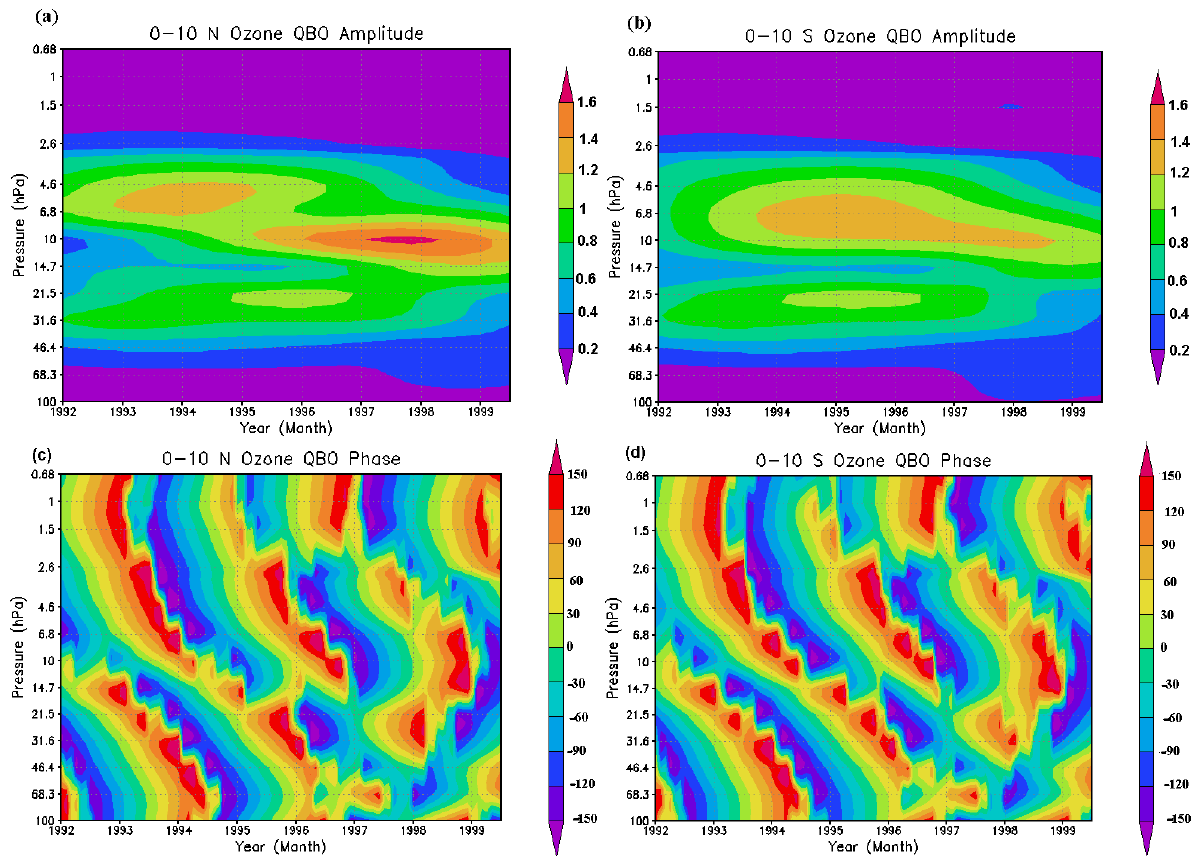
Fig. 3. Variation of amplitude of ozone QBO in time-height domain over (a) 0–10 ◦ N and (b) 0–10 ◦ S. Variation of phase of ozone QBO in time-height domain over (c) 0–10 ◦ N and (d) 0–10 ◦